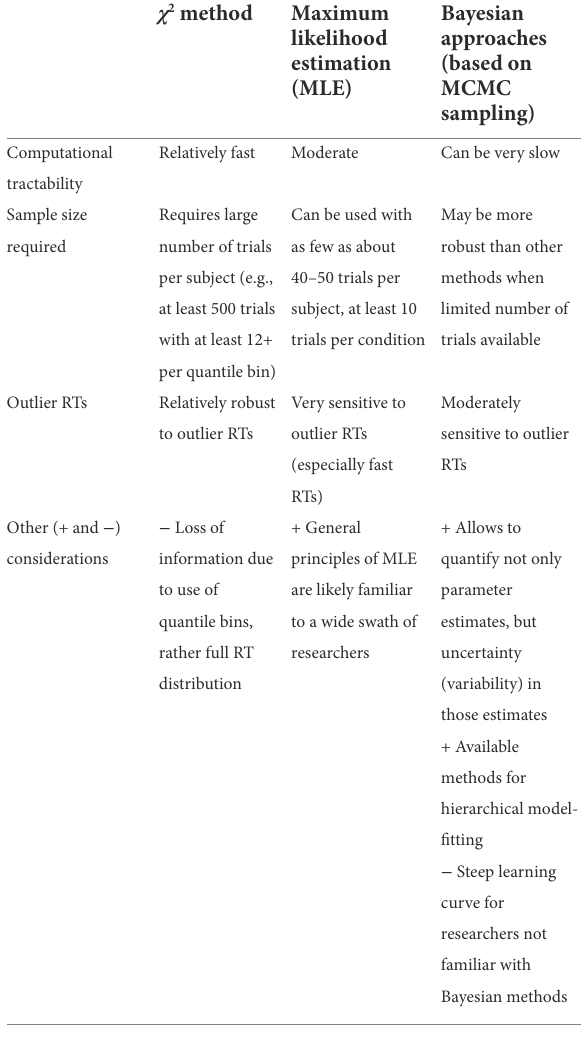
TABLE 2 Comparison of some key features among three approaches to estimate DDM